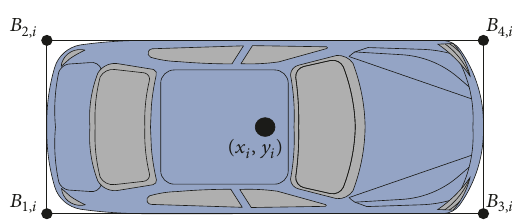
Figure 6: Preceding and rear angles of obstacle vehicles.